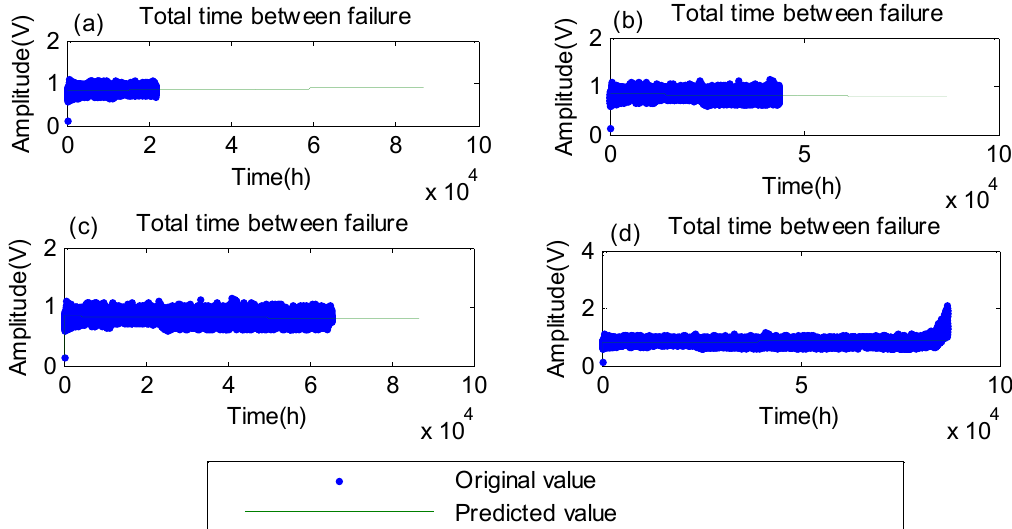
Figure 5. The remaining useful life (RUL) prognostics results with amplitude of original signal utilizing grey theory: ( a ) prognostics result based on 25% of the original data; ( b ) prognostics result based on 50% of the original data; ( c ) prognostics result based on 75% of the original data; ( d ) prognostics result based on 100% of the original data.